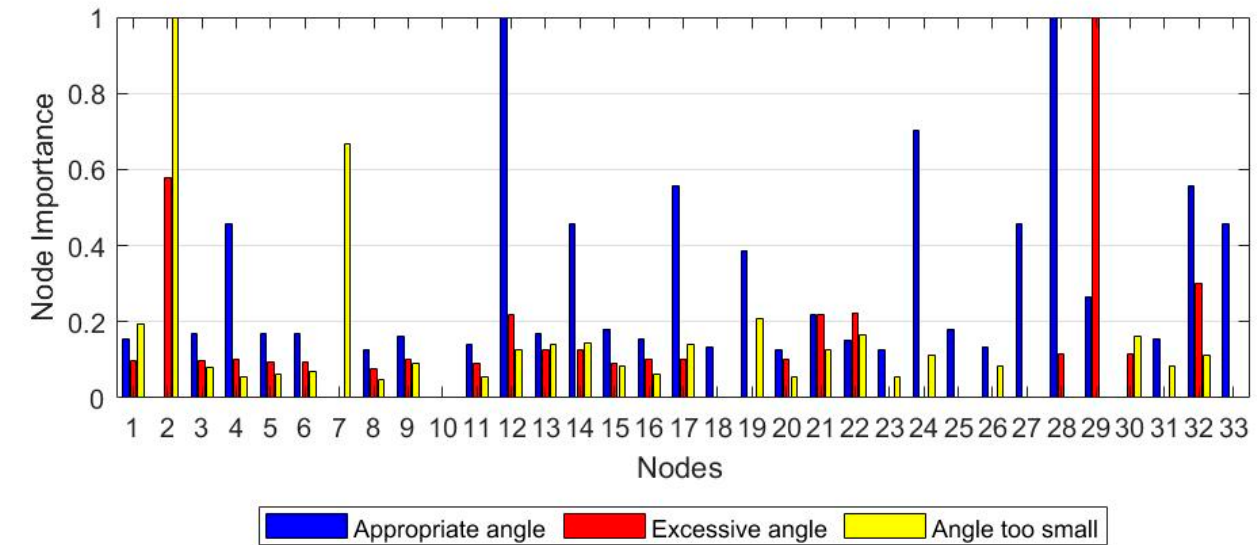
Figure 11. The importance of 33 nodes. The blue bar represents the appropriate angle, the red bar represents the excessive angle, and the yellow bar represents the angle too small.